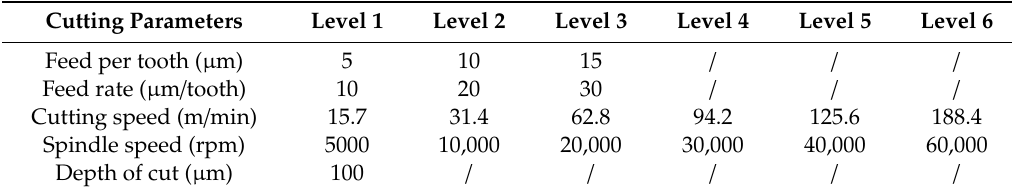
Table 2. Cutting conditions used in the experiments.